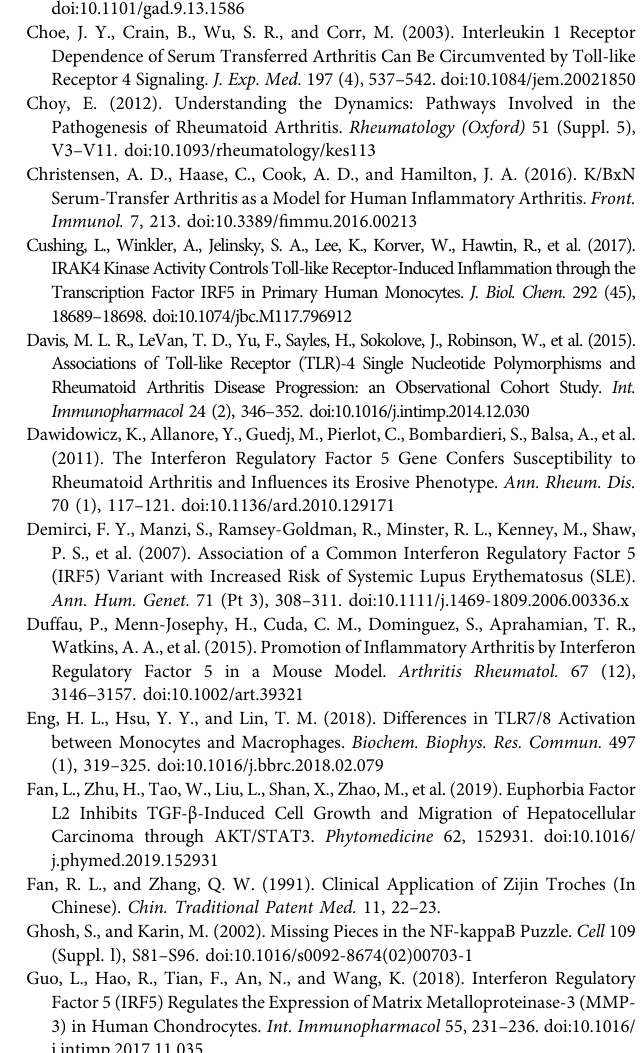
Supplementary Figure S2 | IRF5 expression in RAW 264.7 cells after transfected with IRF5 plasmid. (A) Western blot bands (B) Quanti fi cation of IRF5 expression in R837-stimulated RAW264.7 cells before and after IRF5 overexpression. Data represent the mean values ± SEM of three independent experiments. *p < 0.05, **p < 0.01, ***p < 0.001 were considered as signi fi